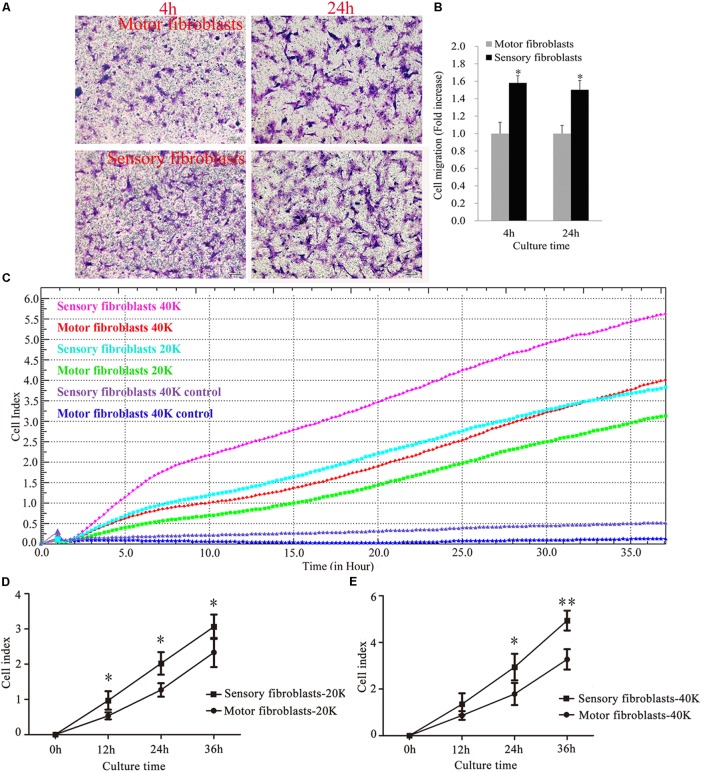
Images showing cultured sensory and motor fibroblasts migrating to the bottom surface of the trans-well membrane after 4 or 24h (A). Scale bar, 100 μm. (B) The histogram demonstrating the quantitative analysis in cell migration between cultured sensory and motor fibroblasts after 4 or 24 h. p = 0.0016 and p = 0.0011, respectively, unpaired t-test, n = 18–19 rats. Migration capacity of motor and sensory fibroblasts in different cell density of 20K, 40K continuously monitored by RTCA for 36 h (C). Quantification of cell migration index of cultured motor and sensory fibroblasts in two different cell density of 20K (D), 40K (E). ∗p < 0.05, ∗∗p < 0.01 vs. motor fibroblasts, unpaired t-test, n = 18 rats.